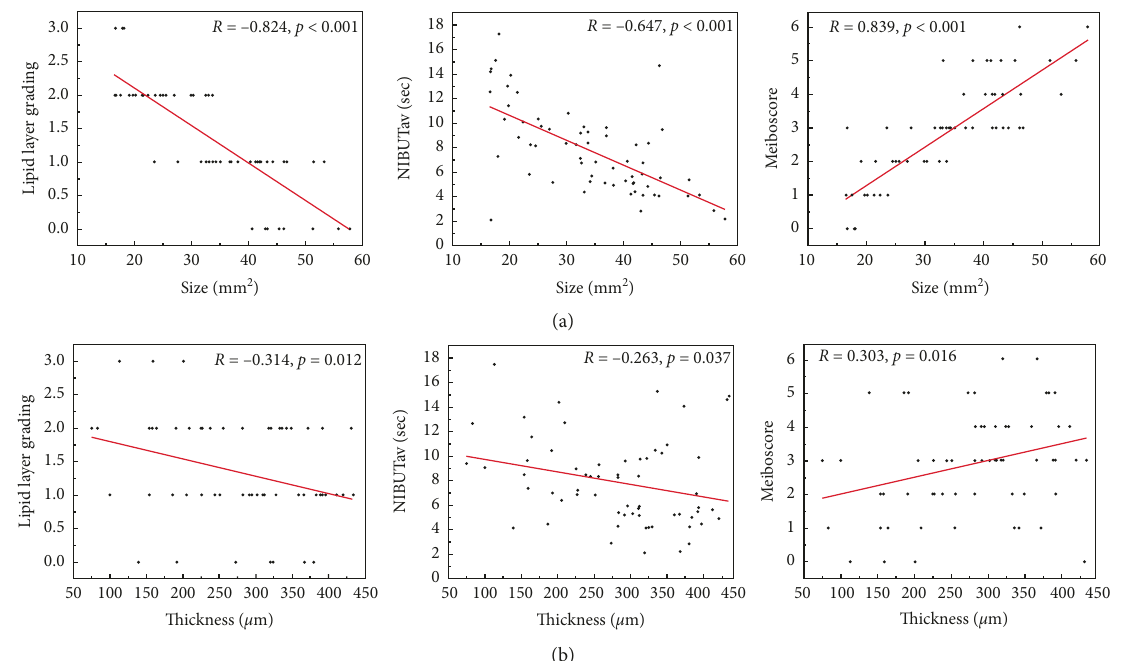
Figure 3: Correlations between pterygium size and thickness and various clinical indicators pre-excision in the pterygium patients: (a) Pterygium size; (b) Pterygium thickness ( R , Pearson’s correlation coefficient, − 1 ≤ R ≤ 1). A p value < 0.05 was considered to be statistically significant. Table 3: Ocular surface disorders and MGs in the pterygium patients after excision surgery. 1 month after surgery 3 months after surgery 6 months after